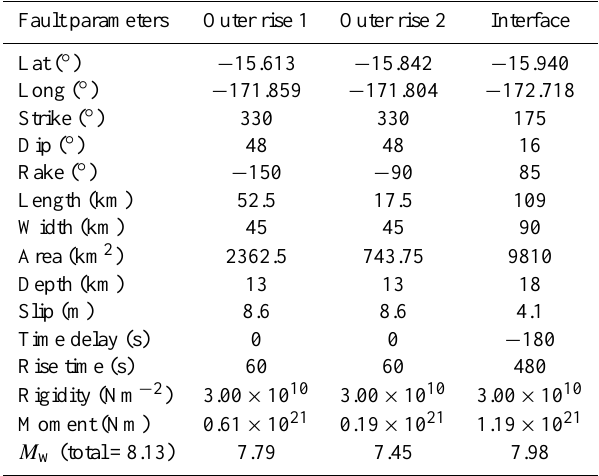
Table 1. Fault parameters used for far-field tsunami-propagation